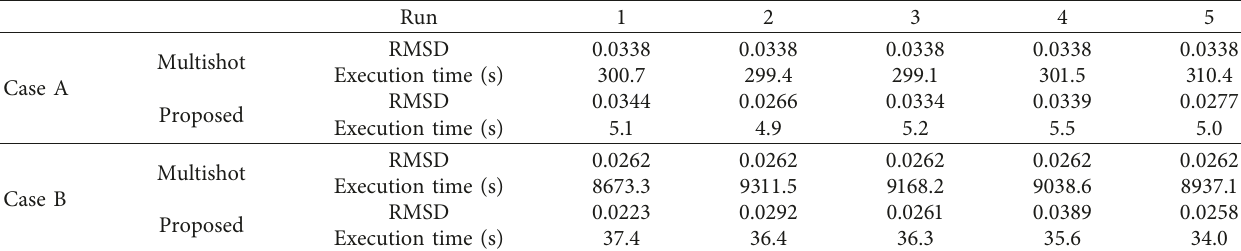
Table 2: Execution times and RMSD results for different methods.